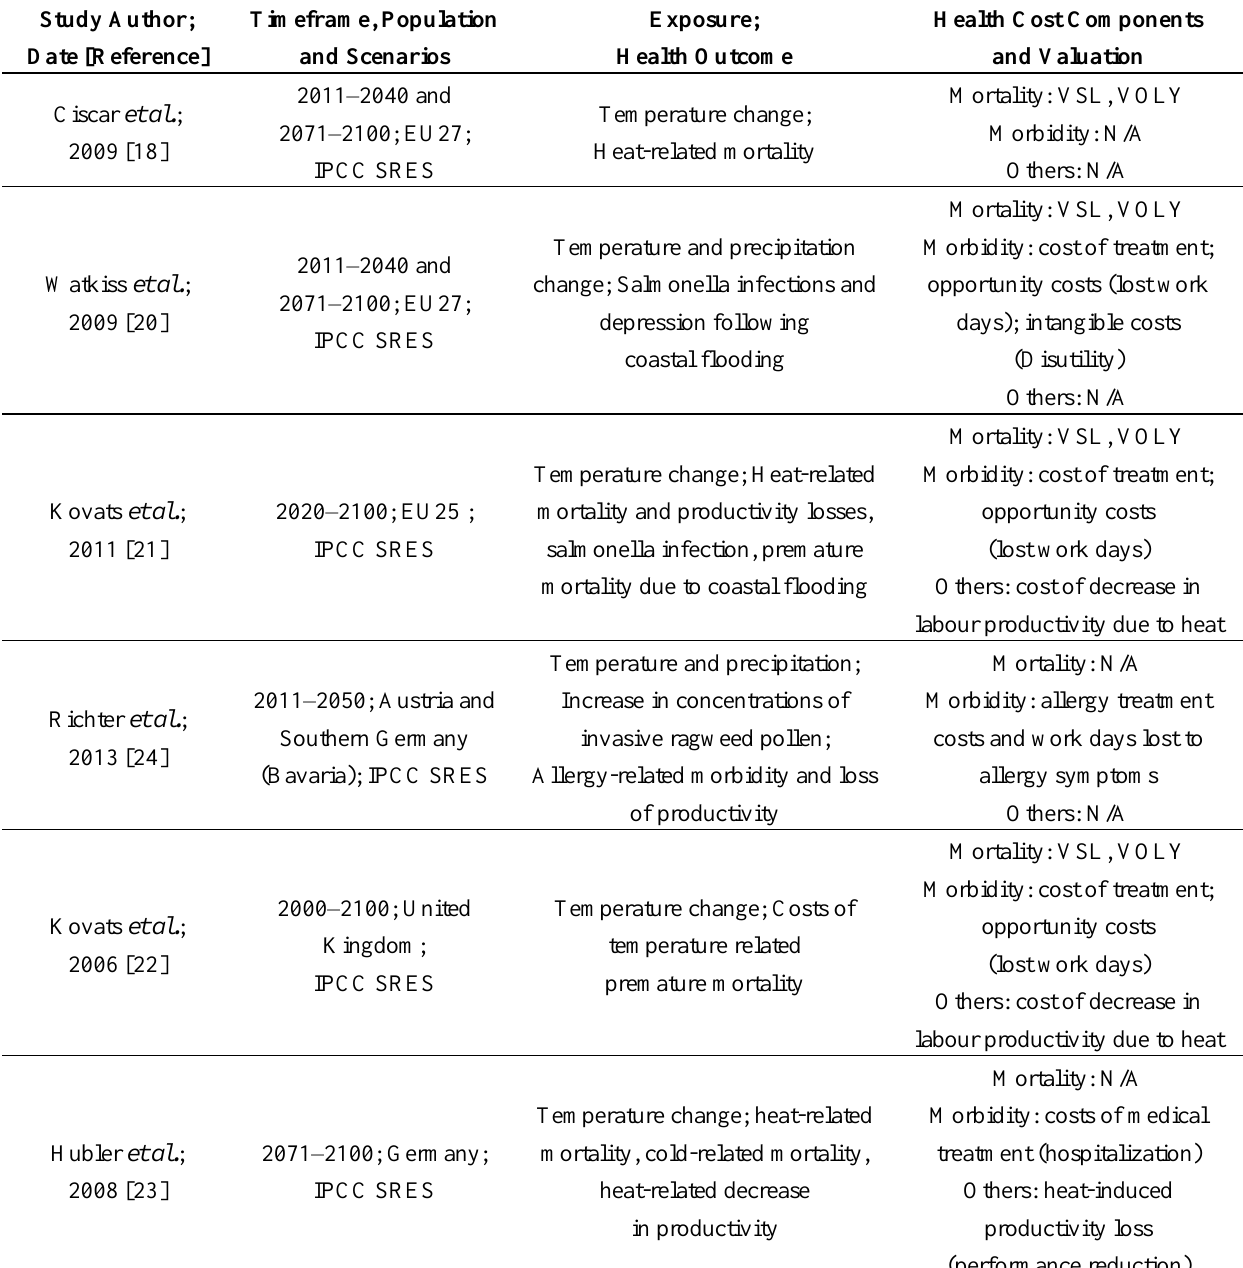
Table 1. Studies aggregating costs of health outcomes attributed to climate